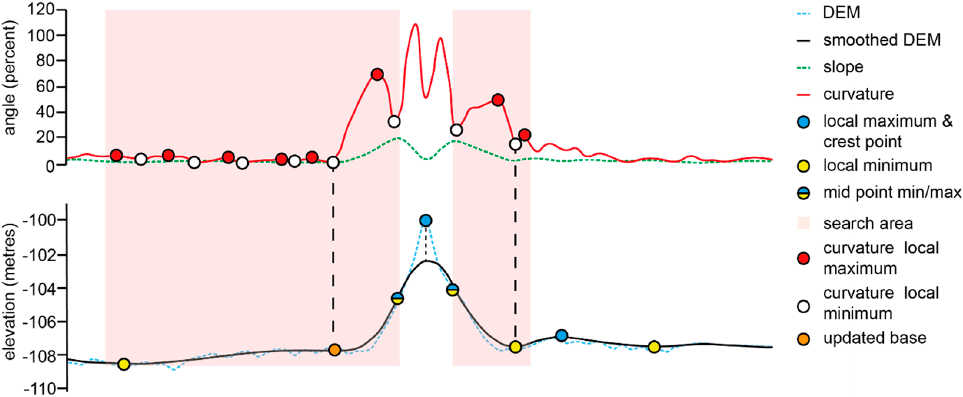
Figure 7. Illustration of the process used to refine the position of the bases along the perpendicular transect. On each side of the bedform, a window of interest is defined by the DEM local minima in addition to 3 pixels and the mid elevation point between DEM local minima and maxima. Within that window, curvature local maxima are tested to evaluate if they correspond to a convex change of elevation and if they are on the right side of the bedform. If so, curvature local minima adjacent to the curvature local maxima and opposed to the crestline point are defined as the base of the bedform. In this example, elevation local minima and the updated base location are identical on the right-hand side of the bedform but show a significant offset on the left-hand side.